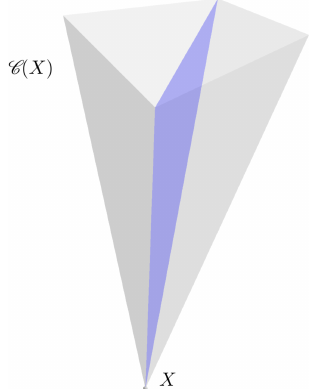
Figure 1 . Schematic illustration of the extended Kähler cone C ( X ) of a singular Calabi-Yau threefold X . Across the blue wall separating distinct chambers, a state becomes